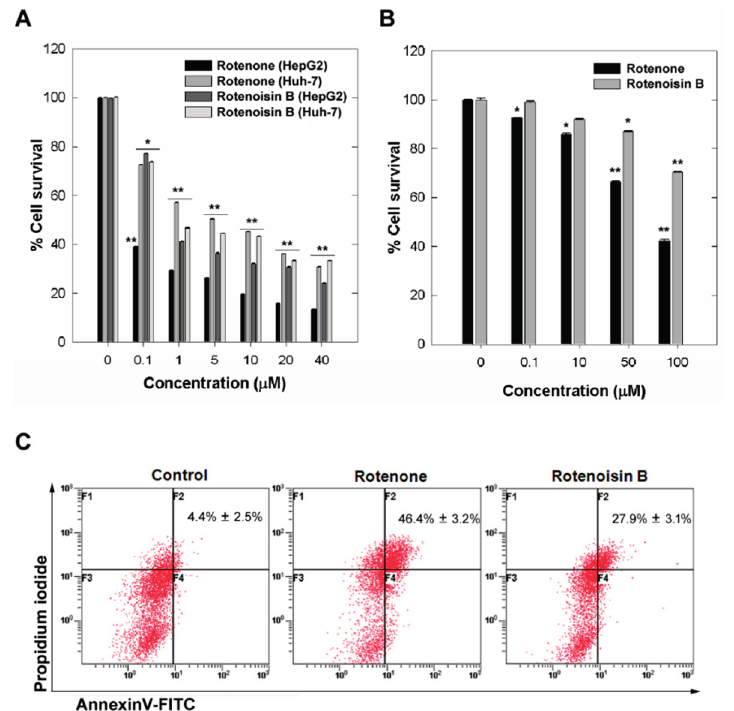
Figure 2. The effect of rotenone and rotenoisin B on the viability of Hepatic cancer cells. ( A ) Cell viability detection by MTT assay in HepG2 and Huh-7 cells after treatment with rotenone and rotenoisin B for 48 h. Each bar indicates means ± SD of four separate experiments. Significant differences from untreated control were indicated by * p < 0.05; ** p < 0.01; ( B ) Cell viability detection in Detroit 551 cells; and ( C ) The percentage of early and late apoptotic cells detection by double staining with annexin V-FITC and PI after Huh-7 cells treatment with rotenone and rotenoisin B. Bottom right, annexin V-FITC positive only considered as early apoptotic cells; top right, annexin V-FITC/PI double-positive considered late apoptotic cells. The percentage of early and late apoptotic cells combinedly